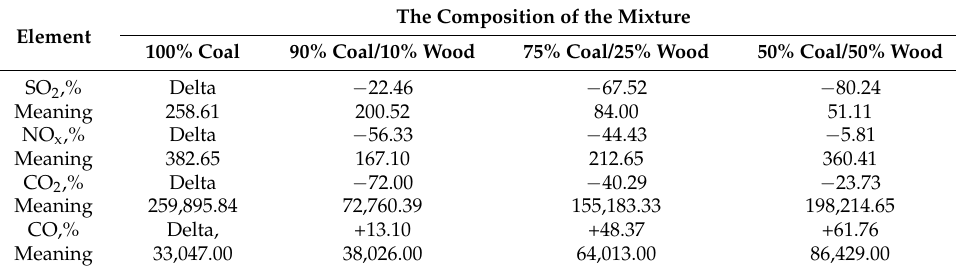
Table 3. Results of calculating the areas under the gas curves for lean coal.